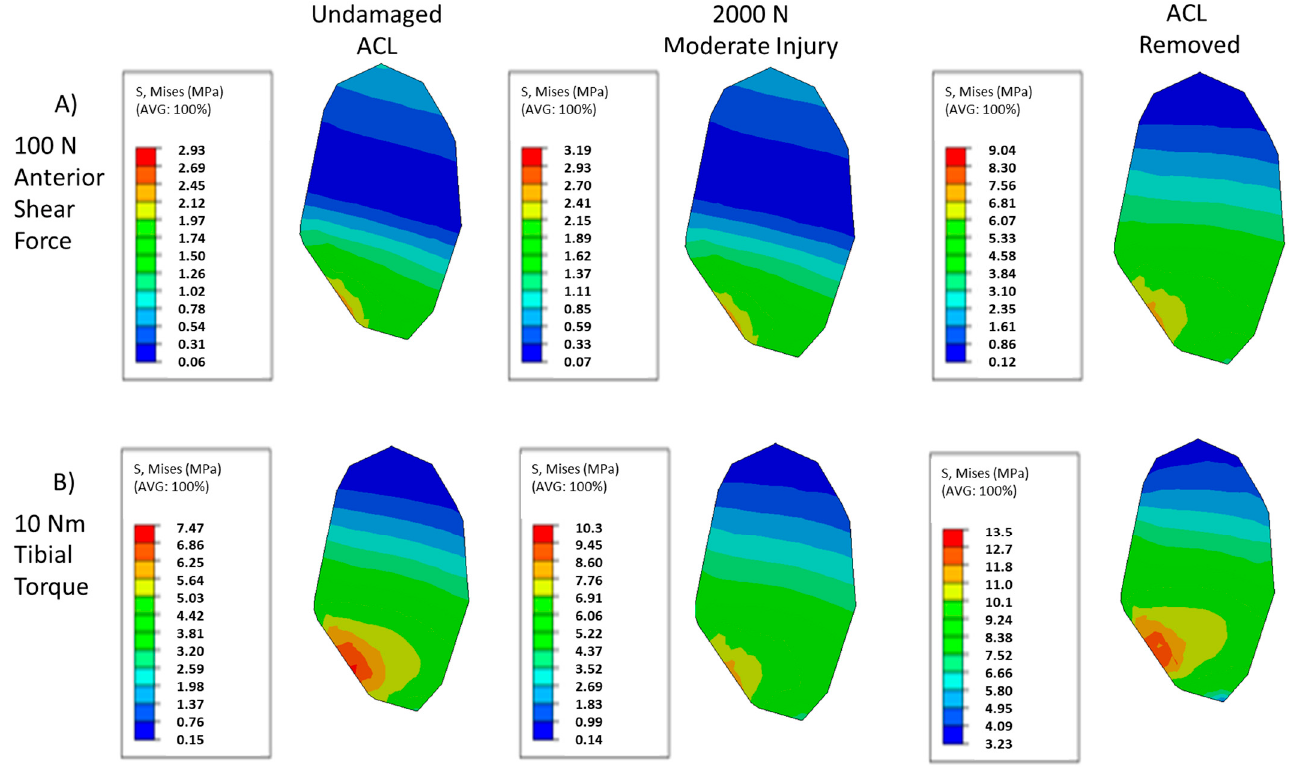
Figure 9. Contour plots of LCL mid-substance von Mises stress (MPa). ( A ) Contour results for at 100 N anterior shear force on the tibia for undamaged, moderate injury, and complete ACL destruction. ( B ) Contour results for at 10 Nm tibial torque on the tibia for undamaged, moderate injury, and complete ACL destruction. In each loading case, the contour changes as damage is induced.